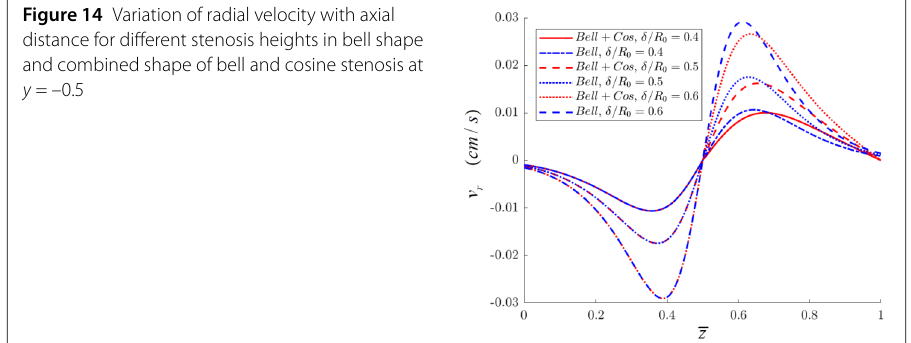
Figure 15 Variation of radial velocity with radial distance for different stenosis heights in cosine shape and combined shape of cosine and bell stenosis at ¯ z =